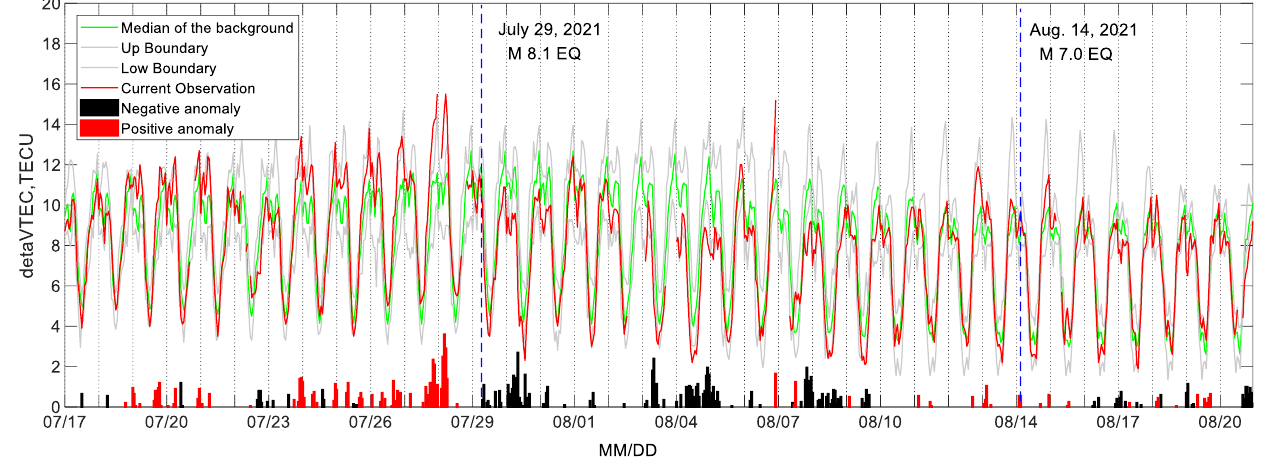
Figure 9. The variation in VTEC over the 29 July 2021 M 8.1 and August 14 M 7.0 Alaska epicenters.